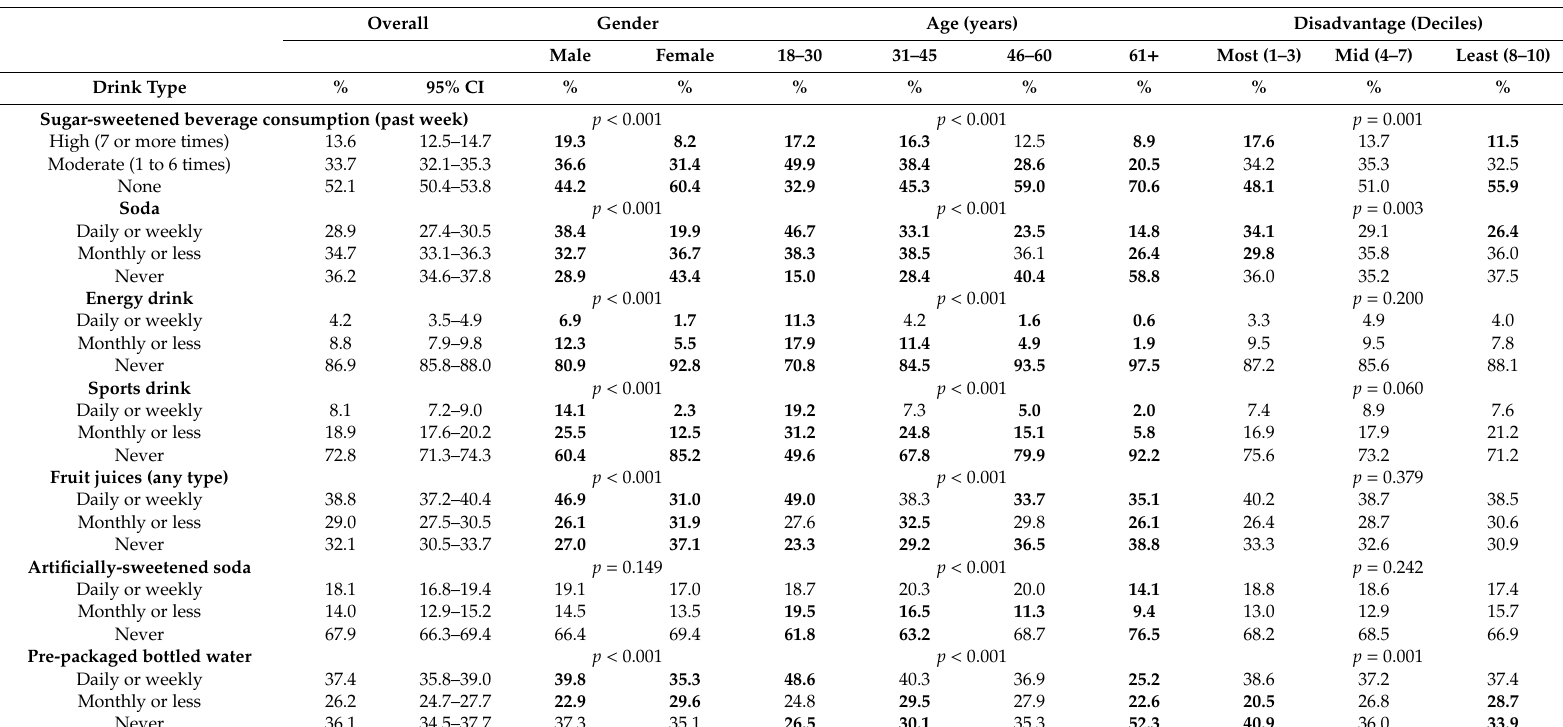
Table 1. Overall consumption for sugary drinks and individual drink types, and associations between consumption of each drink type with gender, age, and socio-economic disadvantage ( n =